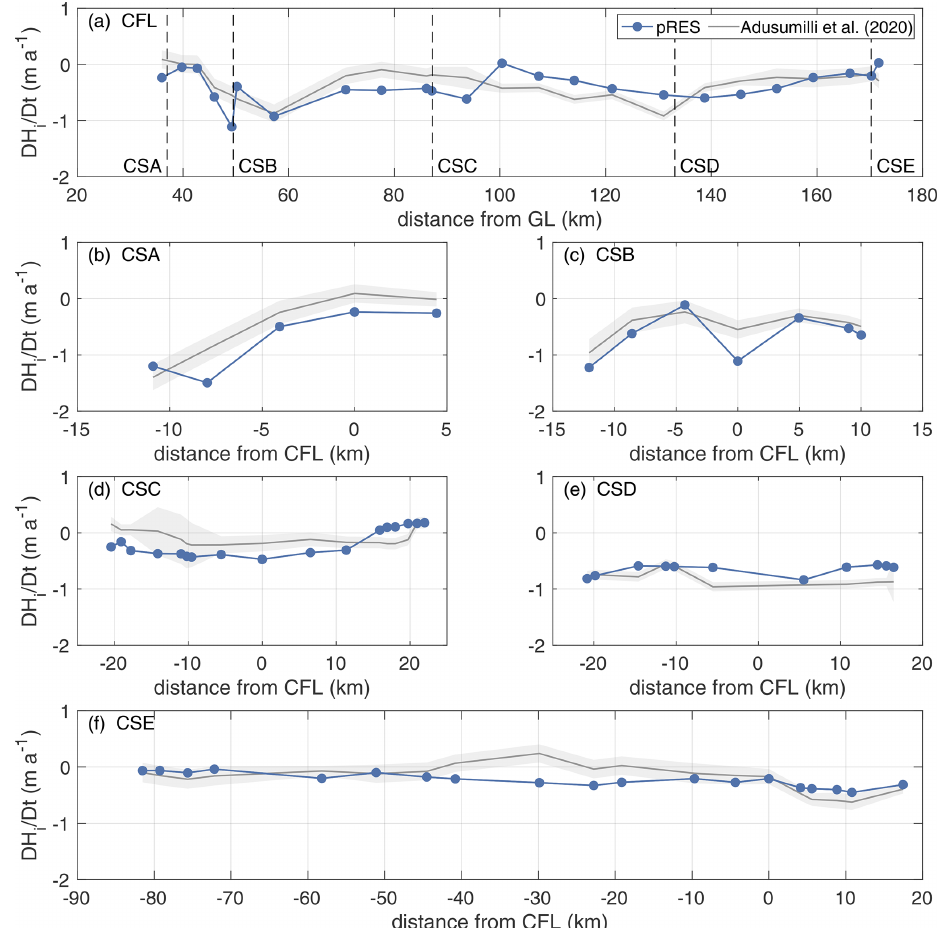
Figure C2. Variation in the ice thickness change D H i / D t (a) along the central flow line (CFL) of Support Force Glacier’s extension on the FIS and (b–f) the cross sections CSA–CSE. Locations are shown in Fig. 1. pRES-derived values are shown in blue. Remote-sensing-derived values are represented by the dark grey line for results published by Adusumilli et al. (2020a). The light grey bounds display the uncertainties. Derived errors of the pRES measurements are too small to visualise. For CFL, the distance refers to the grounding line (GL) of Support Force Glacier and for all cross sections to the CFL with positive distances on the eastern